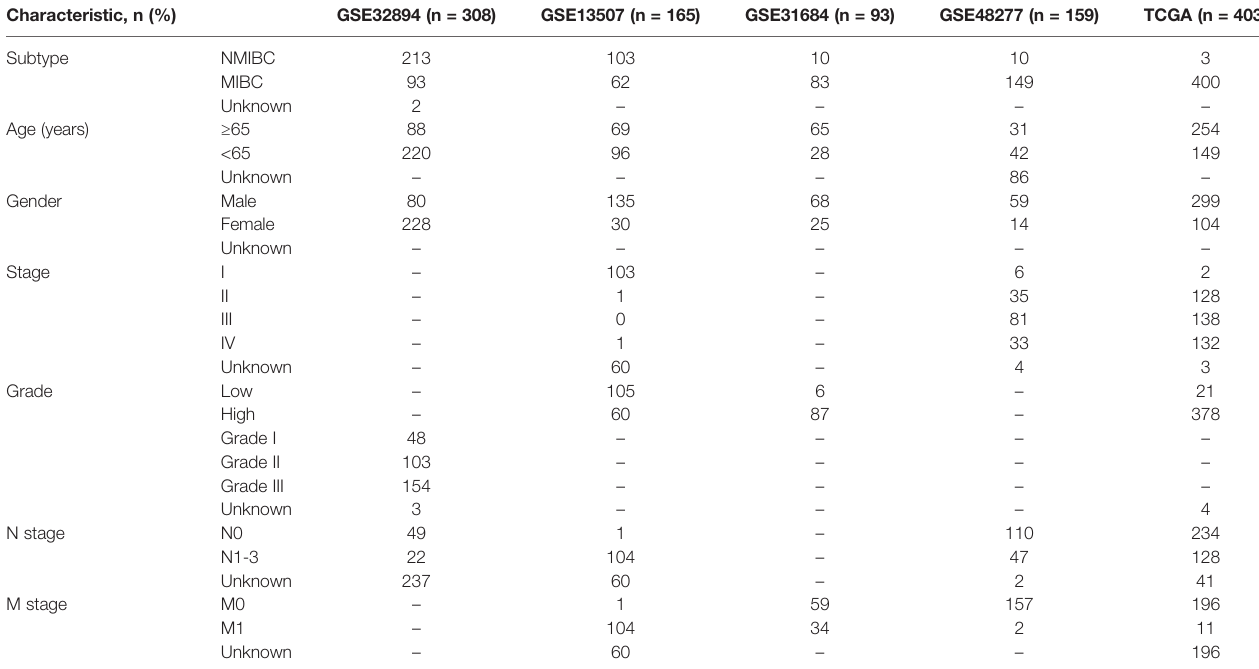
TABLE 1 | Information of data sets used in this study. Characteristic, n